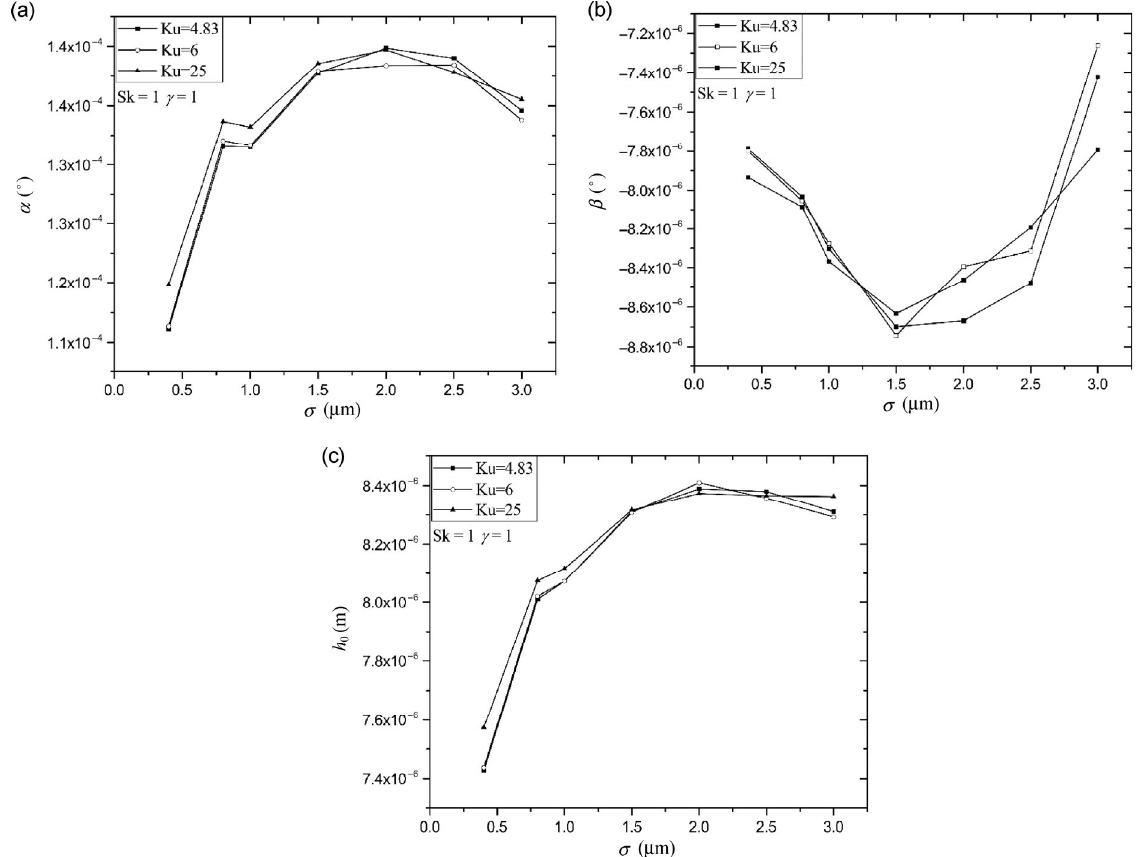
Fig. 7 Tilt angles,  and  and pivot film thickness, h 0 , with various Ku.  a  v.s.  b  v.s.  c  h 0  v.s.  Sk = 1, 